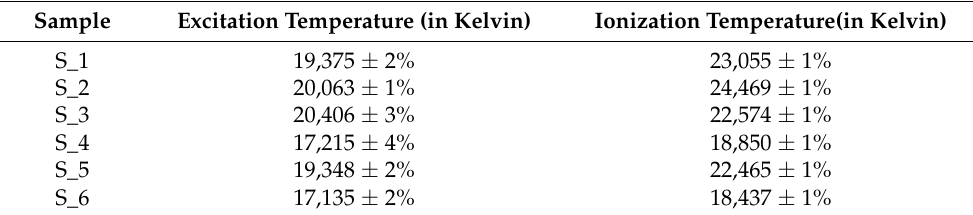
Figure 4. Boltzmann plot for LIB spectra of sample S_1. Table 4. Excitation temperature and ionization temperature calculated by Boltzmann and Saha– Boltzmann plot.